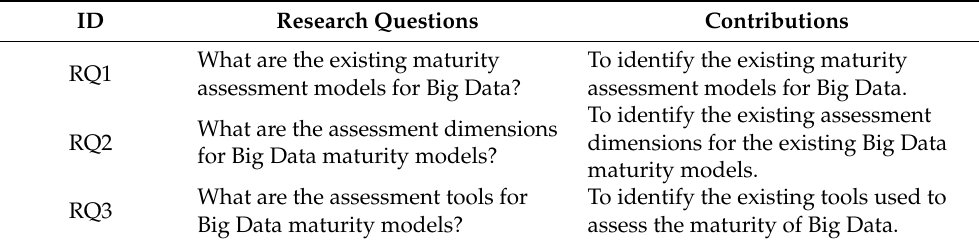
Table 1. The SLR research questions and their contributions.